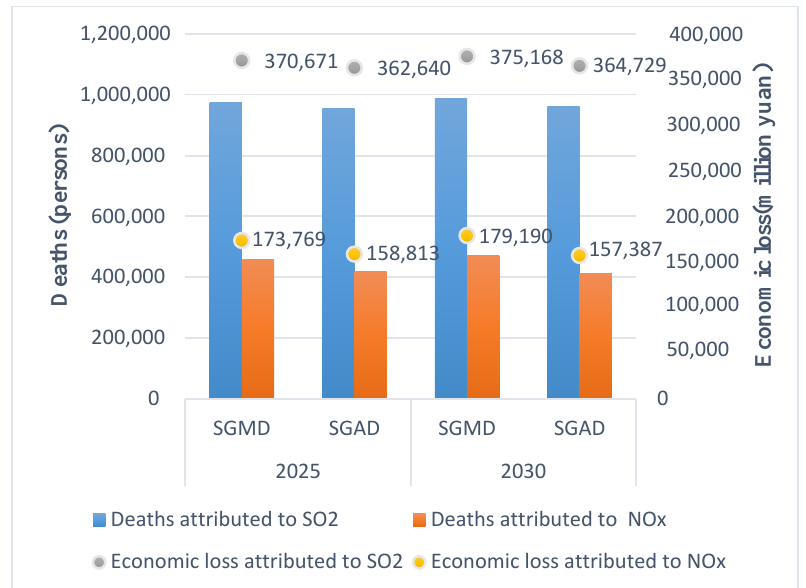
Figure 11. Deaths and economic losses attributed to SO 2 and NO x.